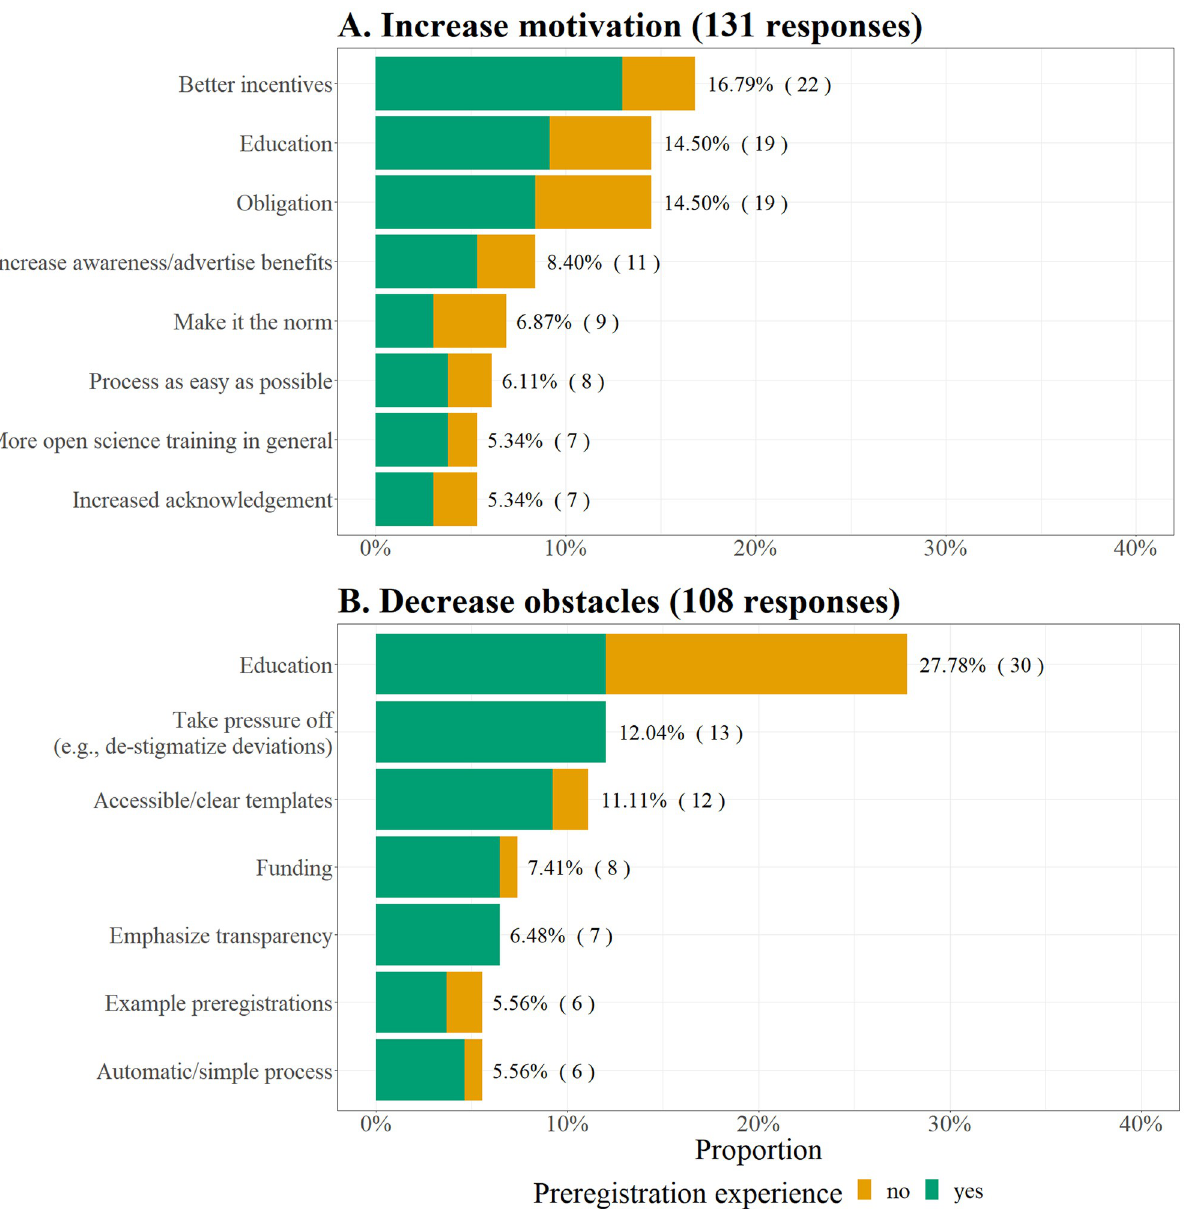
displayed separately for participants with and without preregistration